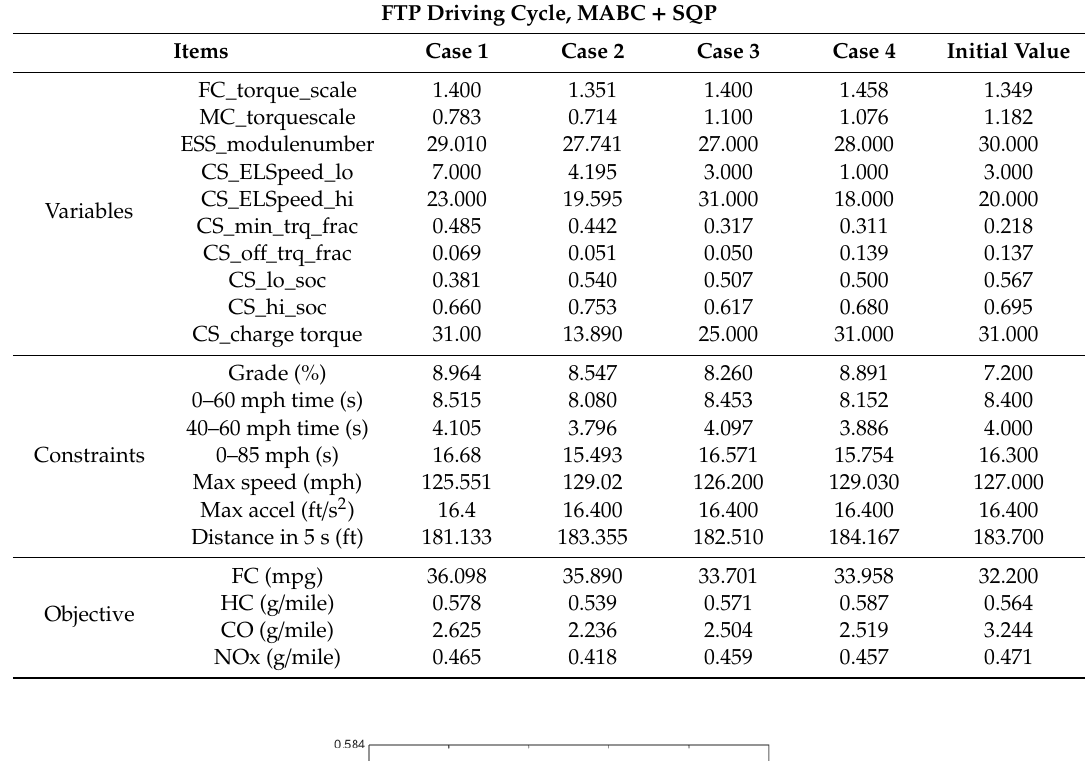
Table 4. Optimization results of FTP driving cycle for MABC + SQP.